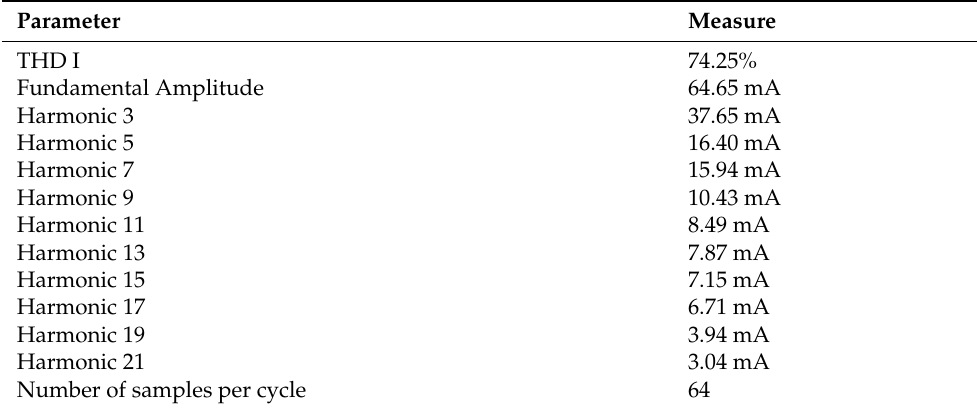
Table 4. Parameters of the standard signal.